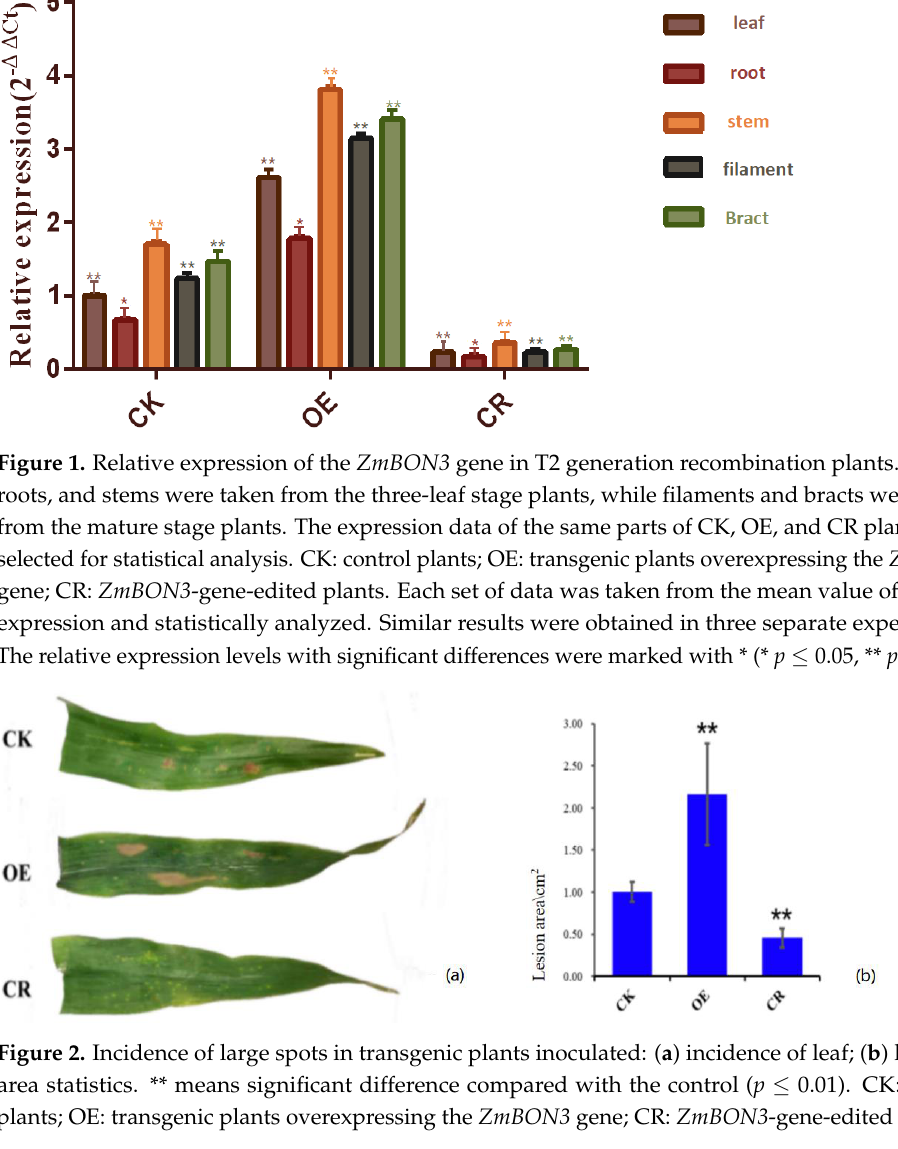
Figure 1. Relative expression of the ZmBON3 gene in T2 generation recombination plants. Leaves, roots, and stems were taken from the three − leaf stage plants, while filaments and bracts were taken from the mature stage plants. The expression data of the same parts of CK, OE, and CR plants were selected for statistical analysis. CK: control plants; OE: transgenic plants overexpressing the ZmBON3 gene; CR: ZmBON3 − gene − edited plants. Each set of data was taken from the mean value of relative expression and statistically analyzed. Similar results were obtained in three separate ex- periments. The relative expression levels with significant differences were marked with * (* p ≤ 0.05, ** p ≤ 0.01).